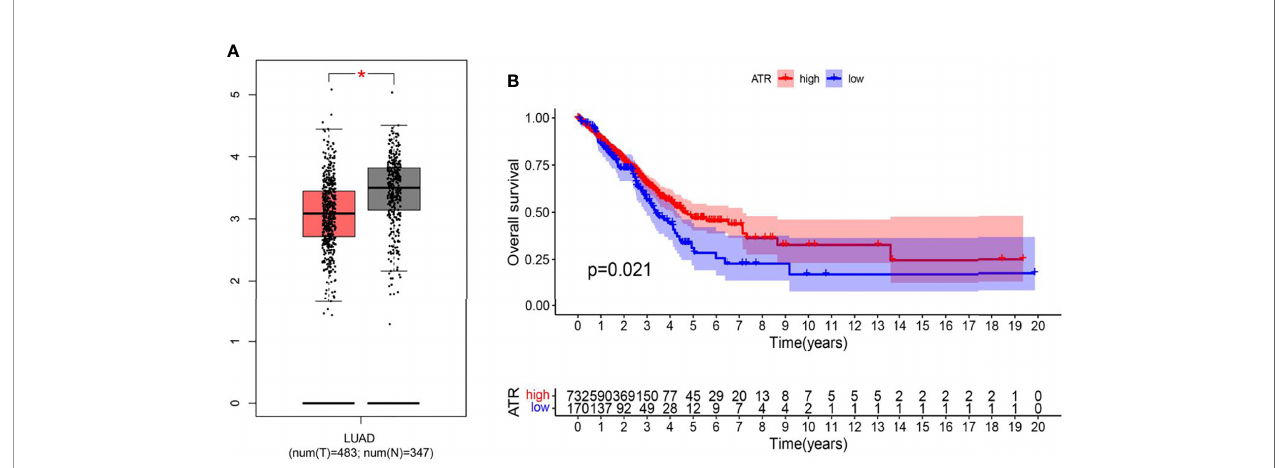
FIGURE 4 | The expression and prognostic differences of ATR in TCGA database. (A) The expression of ATR in LUAD and normal tissues in GEPIA database (Tumor: 483; Normal: 347) (* indicates p < 0.05); (B) Down regulation of ATR is associated with harmful outcome in TCGA database (Tumor: 535; Normal: 59) (p = 0.021).